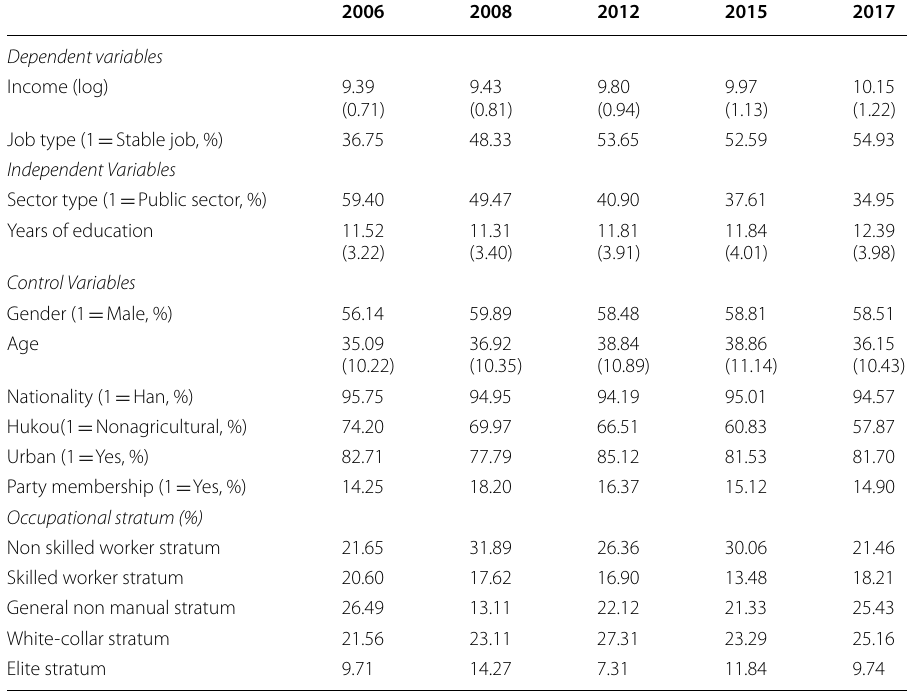
Table 1 Descriptive statistics of relevant